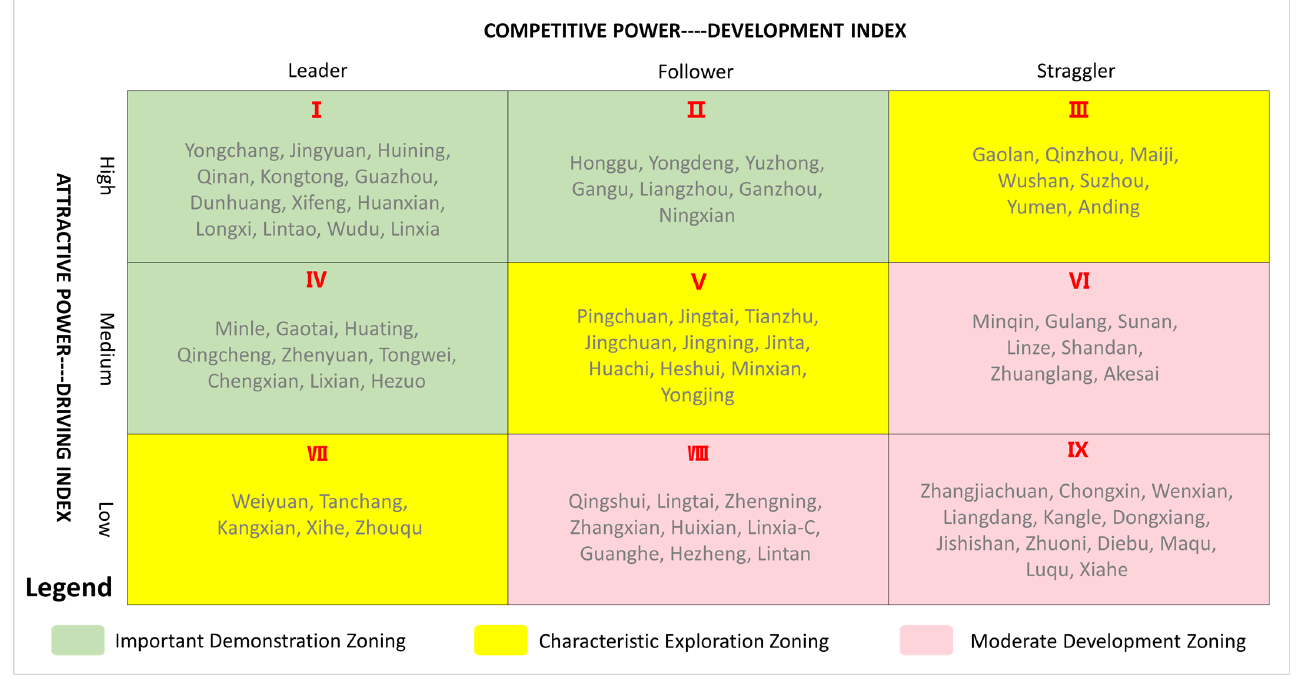
Figure 11. Analysis on spatial zoning of village management digitalization in